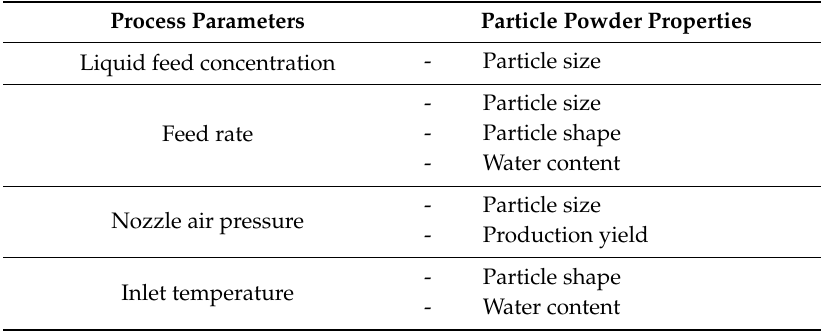
Table 3. Influence of the main spray-drying parameters on particle powder